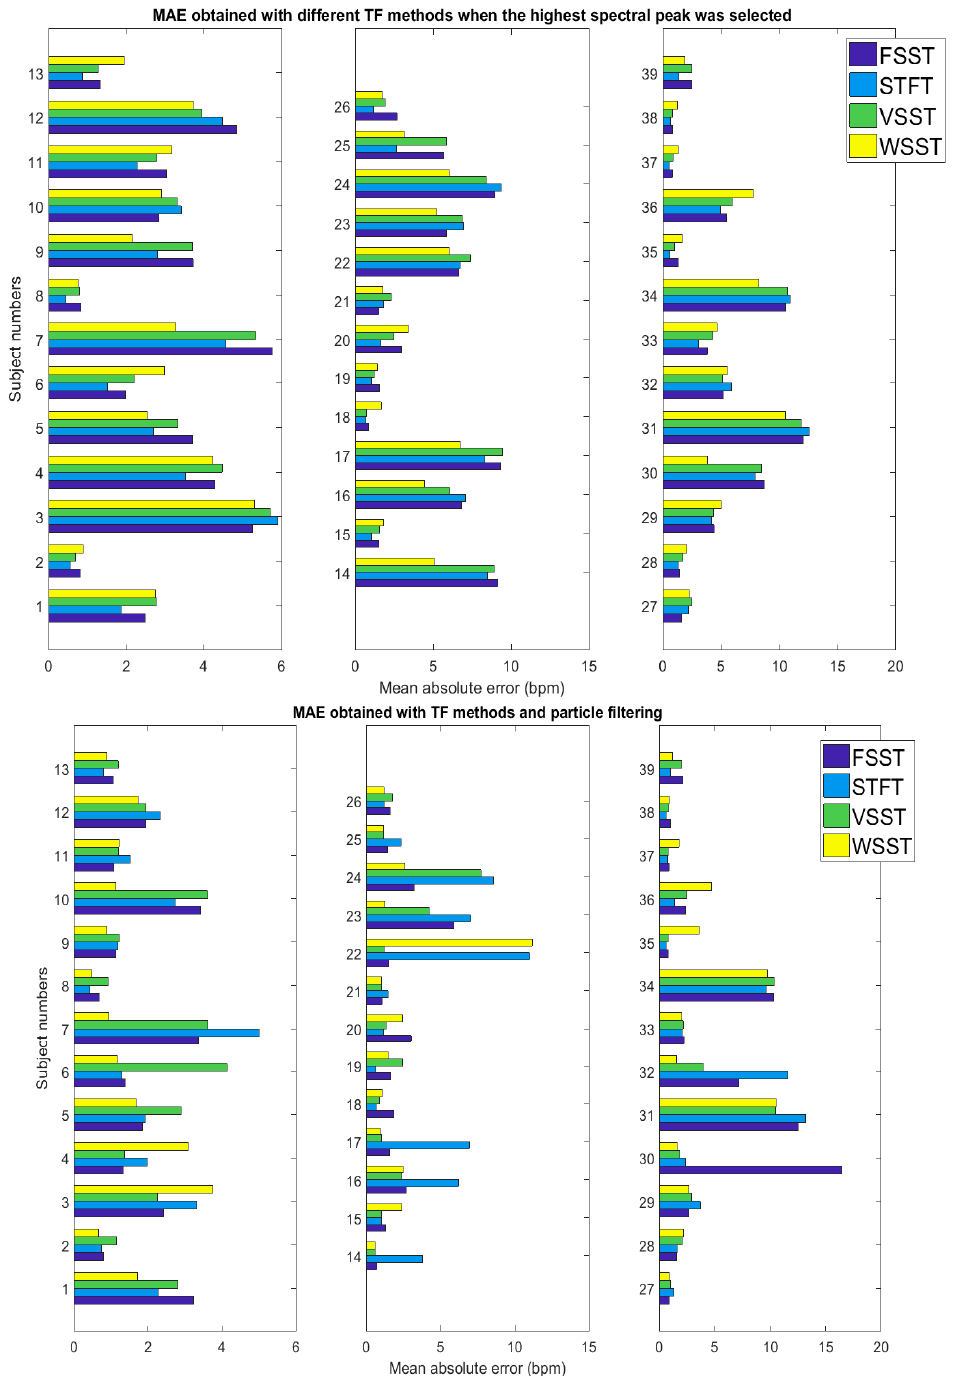
Figure 6. Comparison of mean absolute error between the methods in each subject. Upper: mean absolute error (MAE) for each TF method if only frequency component with highest spectral peak component is selected, disregarding particle filtering. Lower: MAE when particle filtering has been applied.